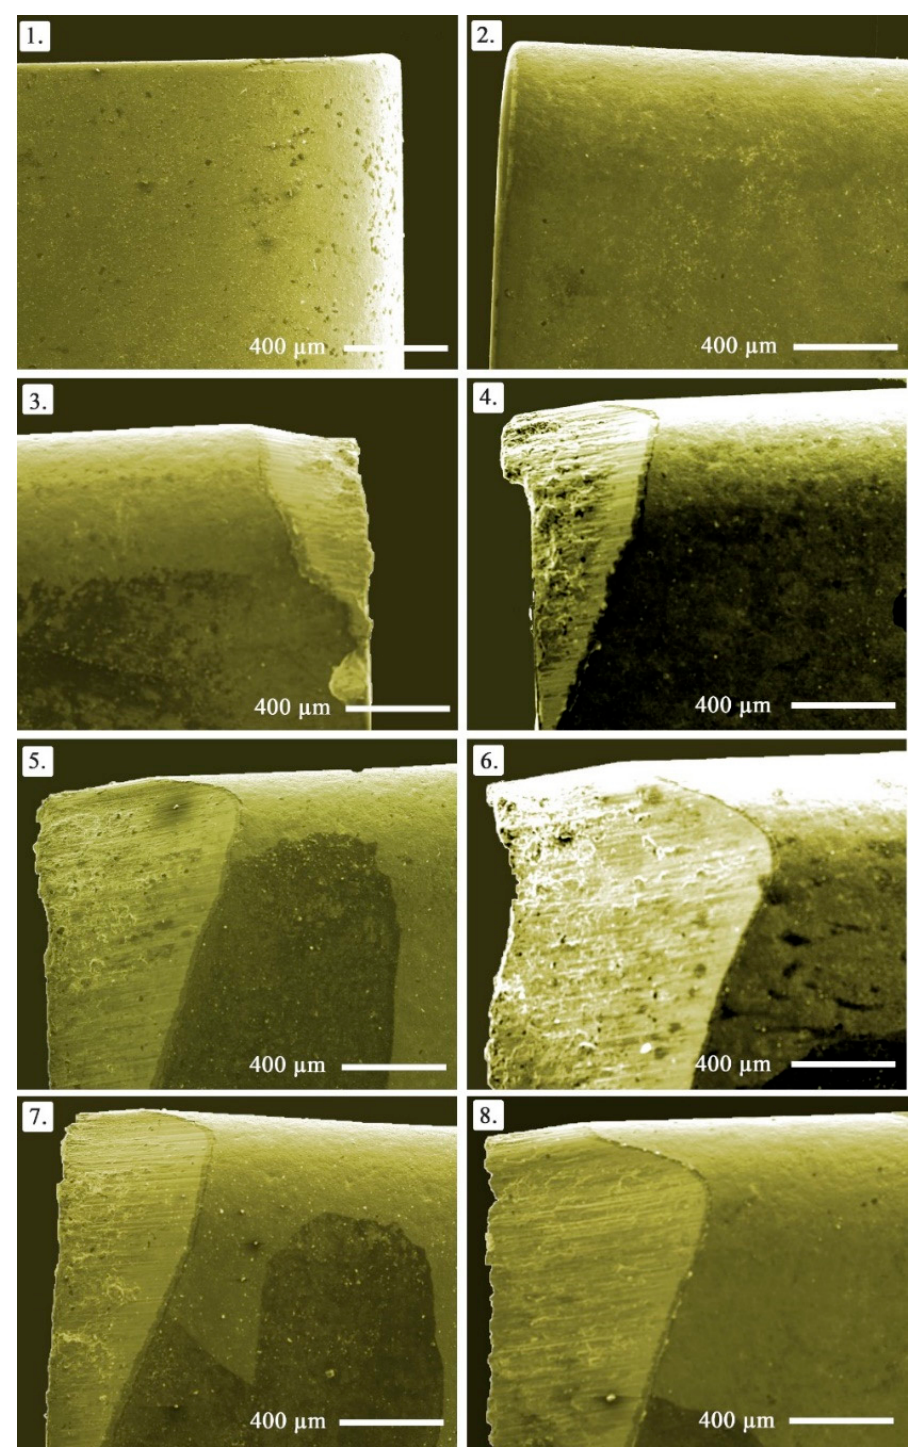
Figure 5. Cutting tool images showing gradual progress in flank wear (Note that the numbers show the order of the test based on design of the experiment).